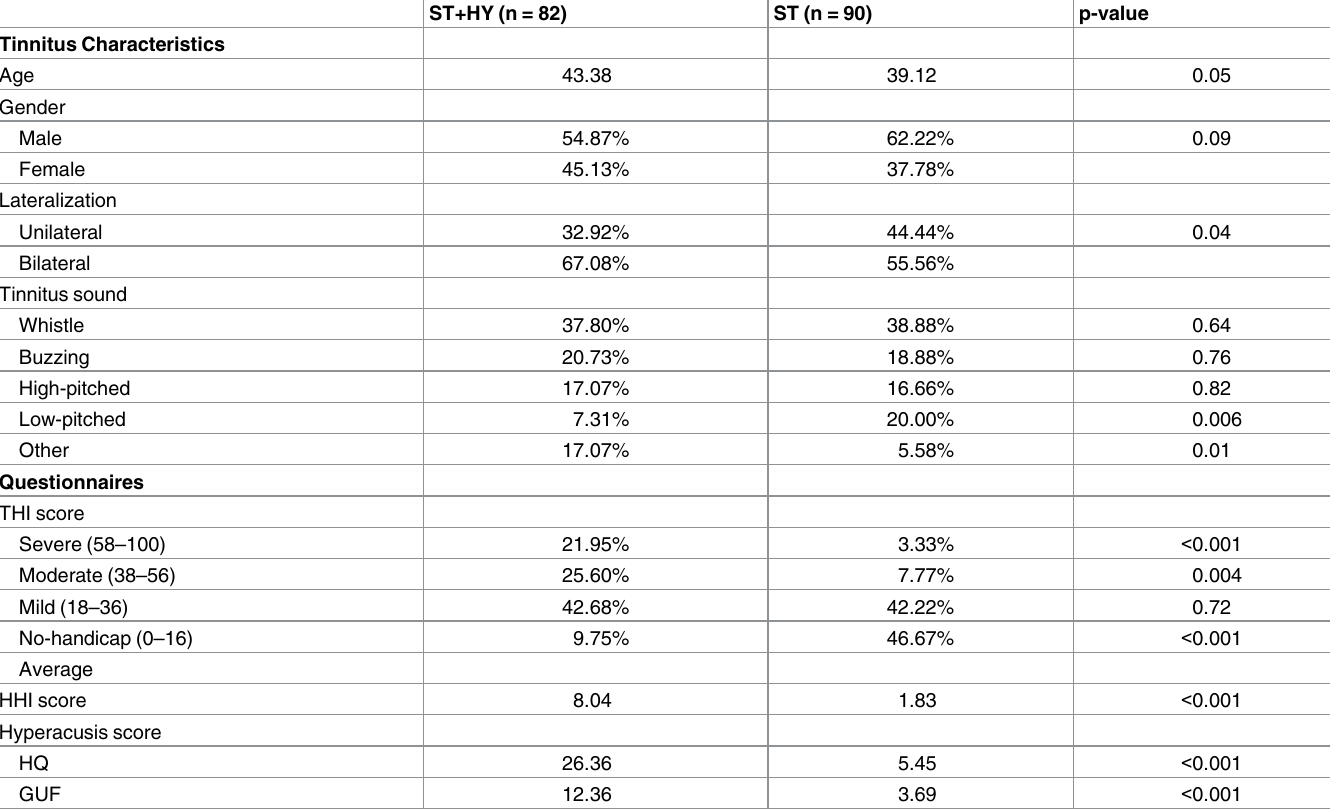
Table 2. Tinnitus characteristics and questionnaire